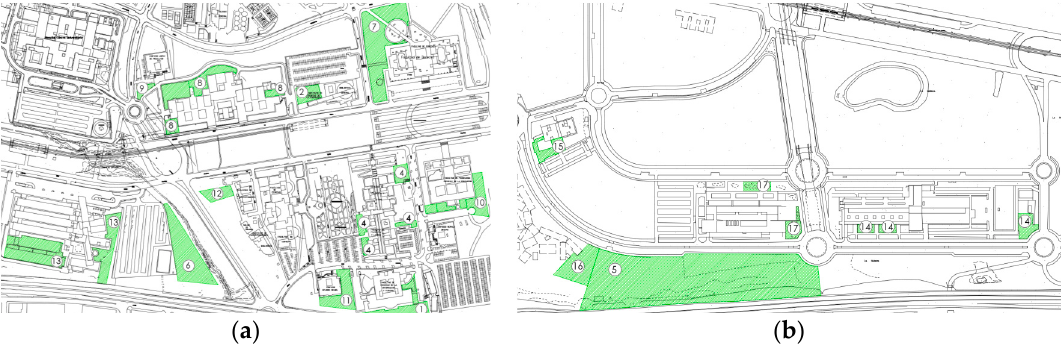
Figure 9. These maps present the campus of University of Malaga, ( a ) is the area denominated Teatinos, ( b ) is the extension of Teatinos (latest zone). The numbered spaces colored in green are the selected places for turning into green islands.